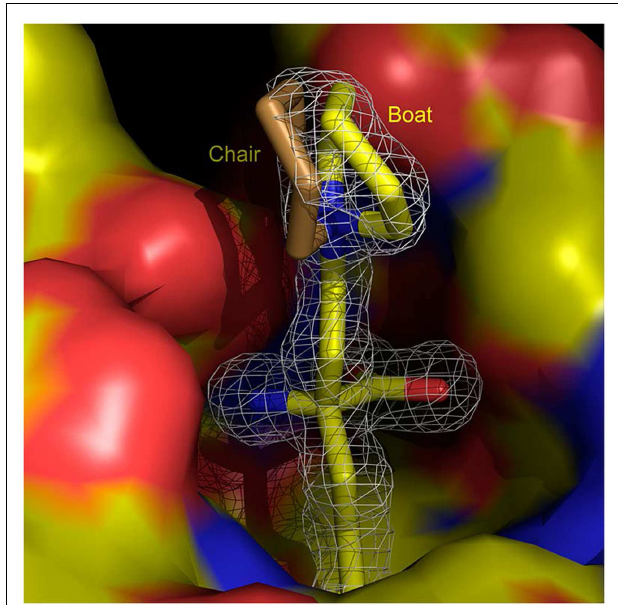
FIGURE 2 | ( R )-2-amino-6-borono-2-(2-(piperidin-1-yl)ethyl)hexanoic acid) and arginase 1 . Structure of ( R )-2-amino-6-borono-2-(2-(piperidin-1-yl) ethyl)hexanoic acid) at the active site of arginase I (surface colored according to charge), shown superimposed with a difference map calculated without the inhibitor model contoured at 3 RMS (white contours).With kind permission from Ref.